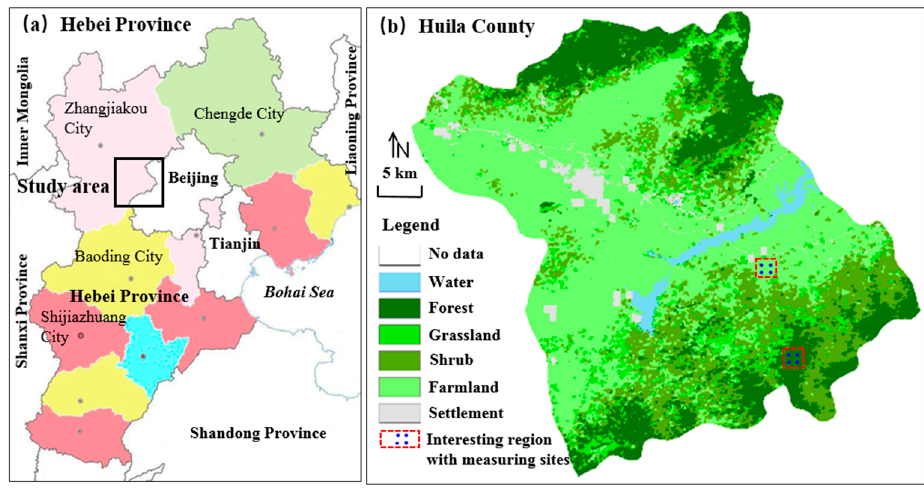
Figure 1. Location of the study area, Huailai County in northern Hebei Province of North China ( a ), and two interesting regions containing the measuring sites ( b ) in Huailai County.